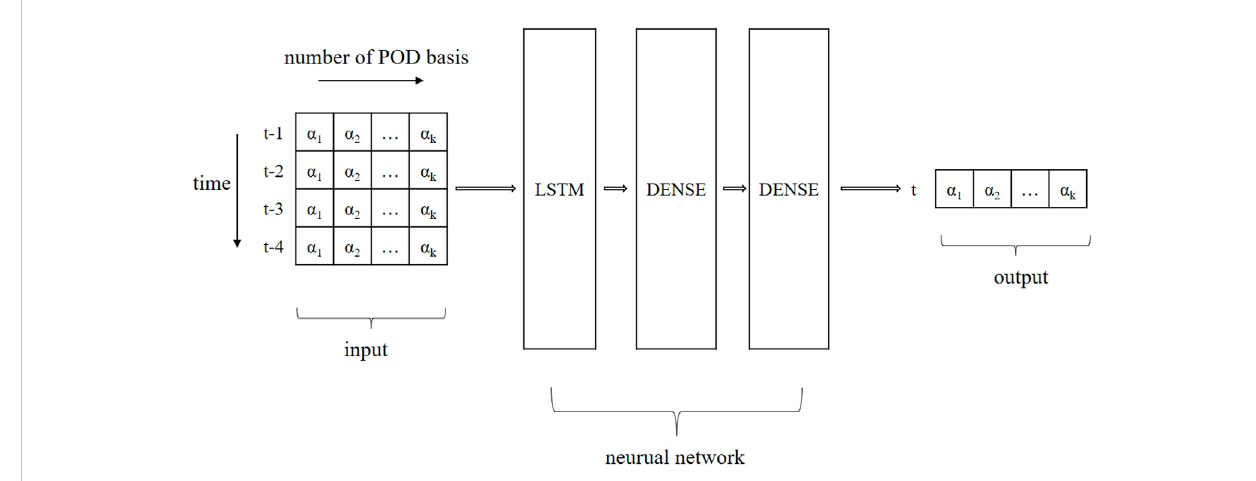
FIGURE 3 LSTM architecture for 2D plate heat conduction.